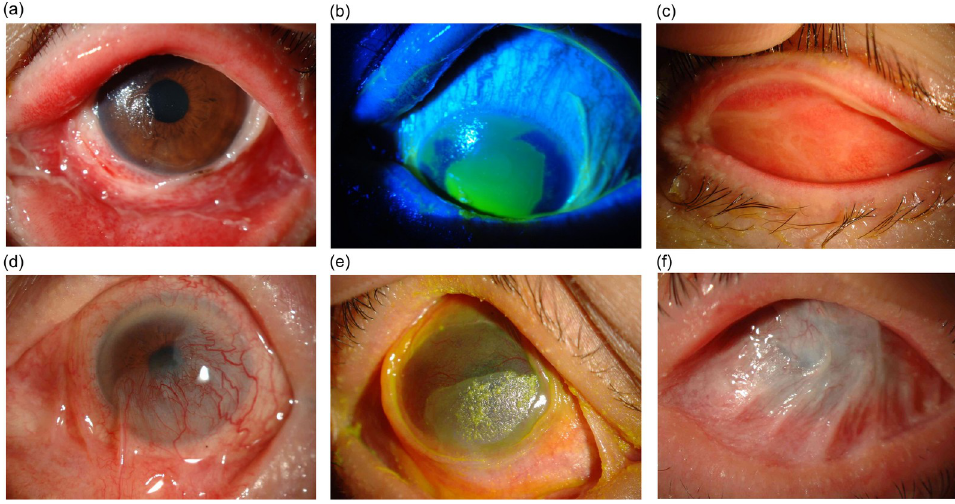
Fig 1. Ocular surface appearances in Stevens-Johnson syndrome/toxic epidermal necrolysis (SJS/TEN). At the acute phase, conjunctivitis ( a ), ocular surface epithelial defect ( b ), and/or pseudomembrane formation ( c ) arise in cases with ocular involvement. At the chronic phase, corneal neovascularization and opacification ( d ), keratinization ( e ), and symblepharon ( f ) develop as ocular